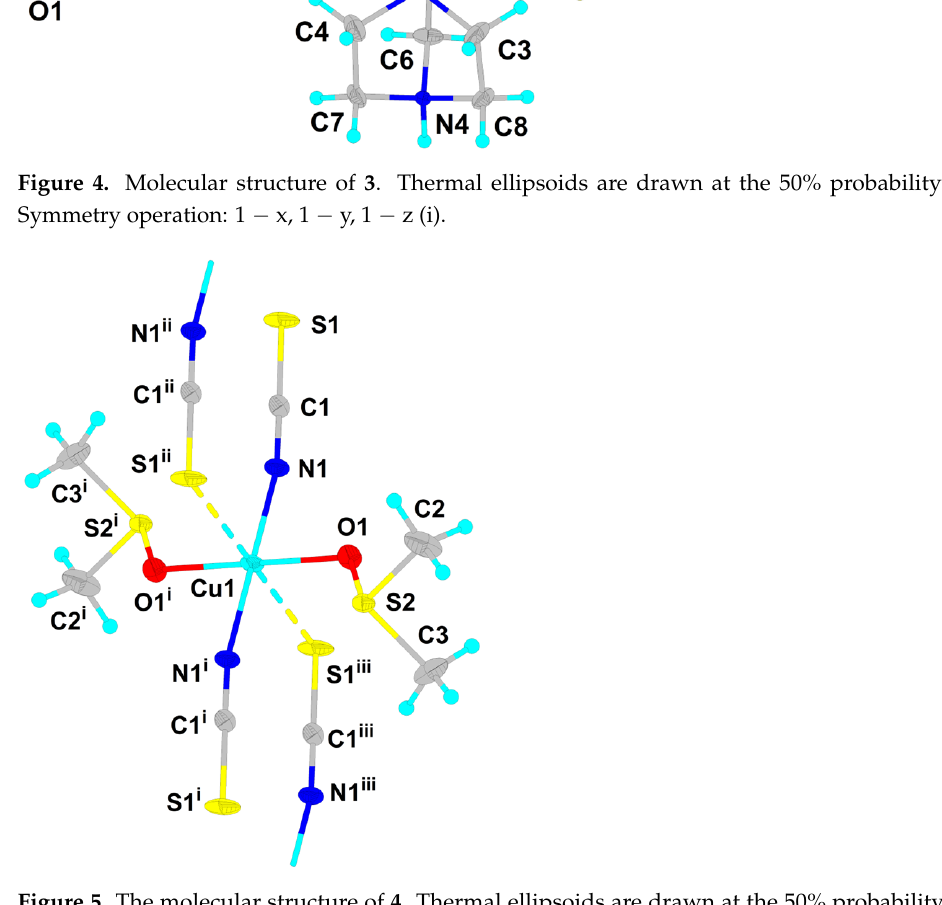
Figure 5. The molecular structure of 4 . Thermal ellipsoids are drawn at the 50% probability level. Symmetry operations: 1 − x, 1 − y, 1 − z (i); −x, 1 − y, 1 − z (ii); 1 + x, y, z (iii).